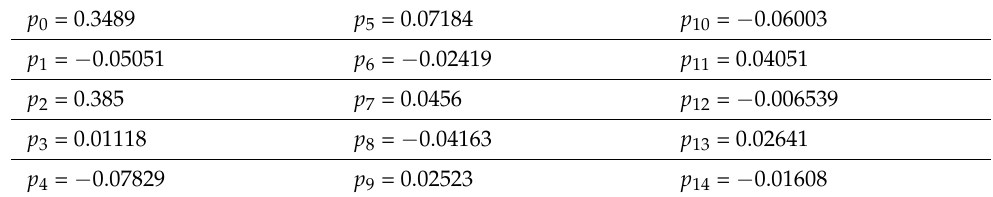
Table 2. Polynomial coefficients of Equation (3).